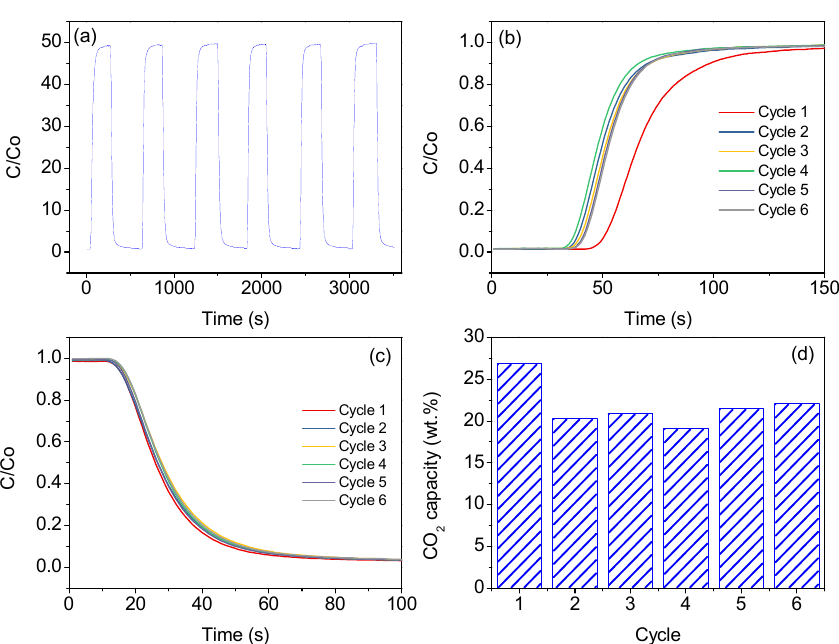
Figure 7. ( a ) Continuous CO 2 capture profile, ( b ) adsorption isotherm, ( c ) desorption isotherm, and ( d ) CO 2 capture capacity of sample CNHP500-2(2-1) for 6 consecutive cycles at 50 ml/min and room condition (1 atm, 25 °C).